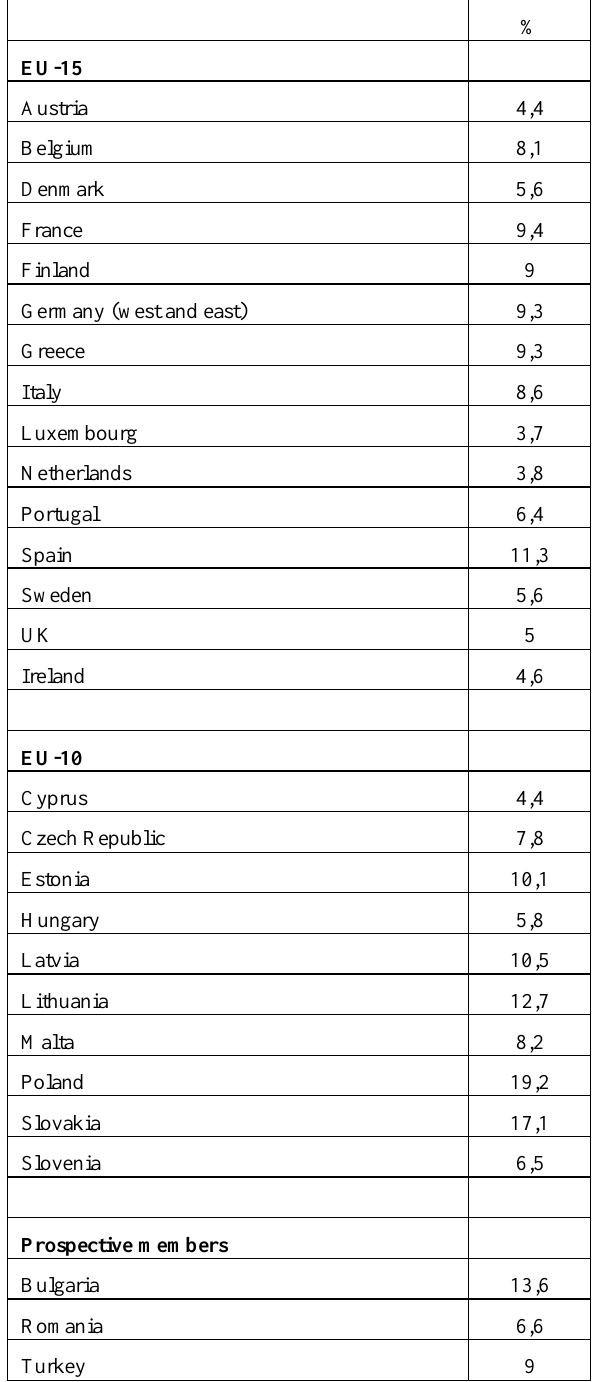
Table 8. Resident working population by nationality (%) 2005